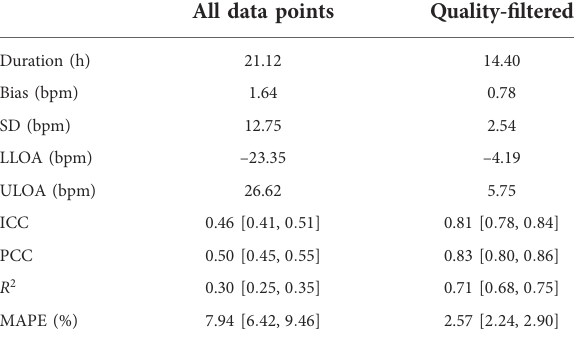
TABLE I. The resulting statistical values averaged over all 97 patients. Values are average duration, bias, standard deviation (SD), lower limit of agreement (LLOA), upper limit of agreement (ULOA), Intraclass Correlation Coef fi cient (ICC), Pearson ’ s Correlation Coef fi cient (PCC), the coef fi cient of determination, R 2 , in this case the squared Pearson ’ s correlation coef fi cient, and the mean absolute percentage error (MAPE).